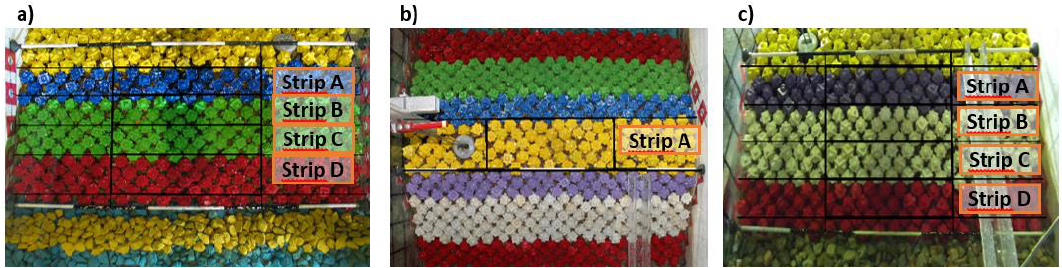
Figure 5. Application of the Virtual Net method to measure armor damage to the front slope ( a ), crest ( b ), and rear slope ( c ).